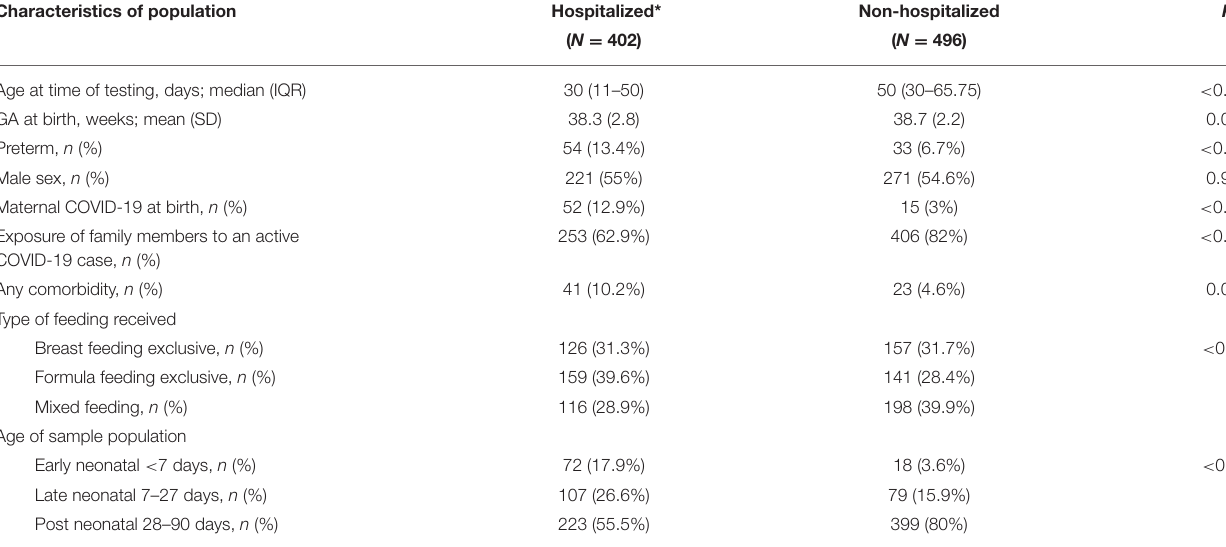
TABLE 3 | Characteristics of population among hospitalized and non-hospitalized.